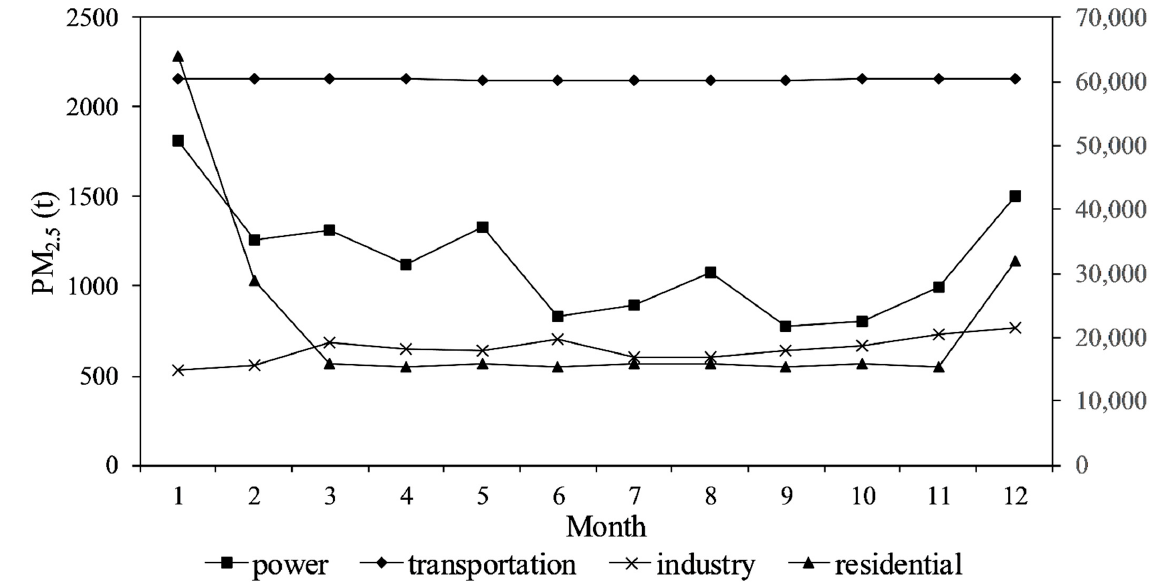
Figure A1. PM 2.5 emissions of various departments in Sichuan Basin based on 2017 MEIC inventory statistics. The transportation department corresponds to the left axis, and the other departments correspond to the right axis.